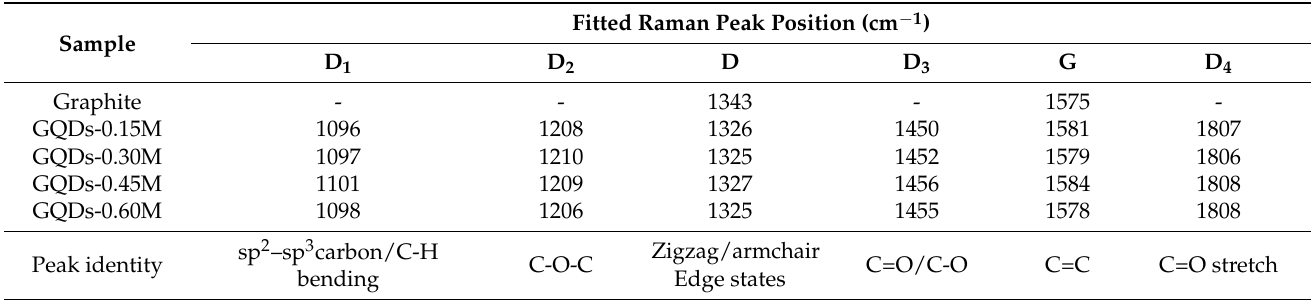
Table 2. Summary of the fitted Raman peak position in the region 1050–1950 cm − 1 . The peak identity is also assigned to each Raman peak